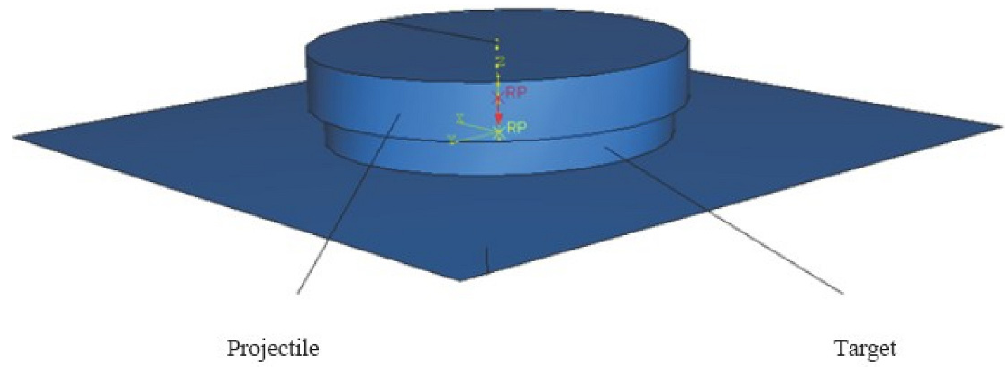
Figure 8. Illustration of the impact on a foam.